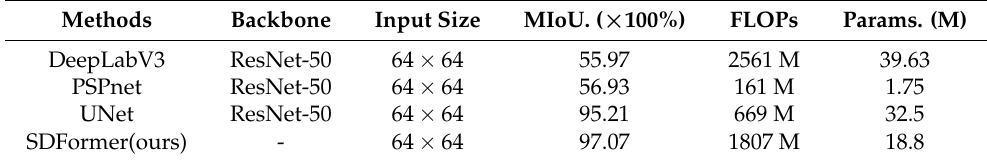
Table 1. Result on plate dataset.